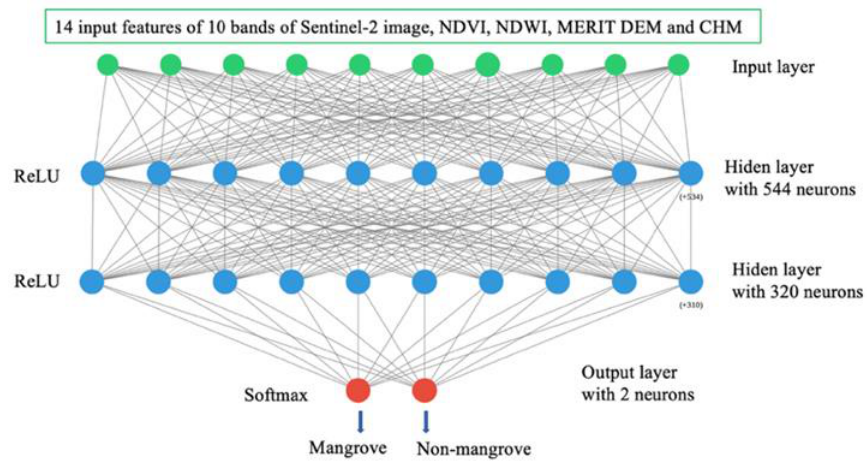
Figure 11. Proposed ANN model and input dataset for classification of mangrove distribution.